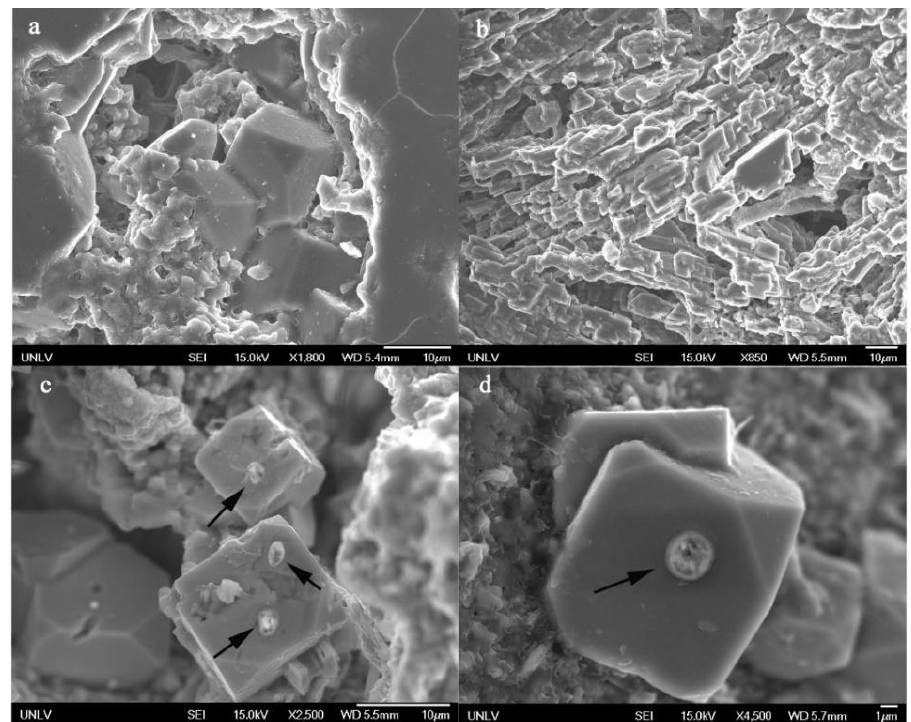
Figure 9. Images of crystals in the vesicles. ( a ) Euhedral quartz and sanidine in the cavity. ( b ) Subhedral sanidine aggregates. ( c - d ) Electron beam (15 kV/10 nA) damages the arsenogoyazite-like crystals (pointed by the arrow). The beam damage indicates the weak bounding feature of this crystal.